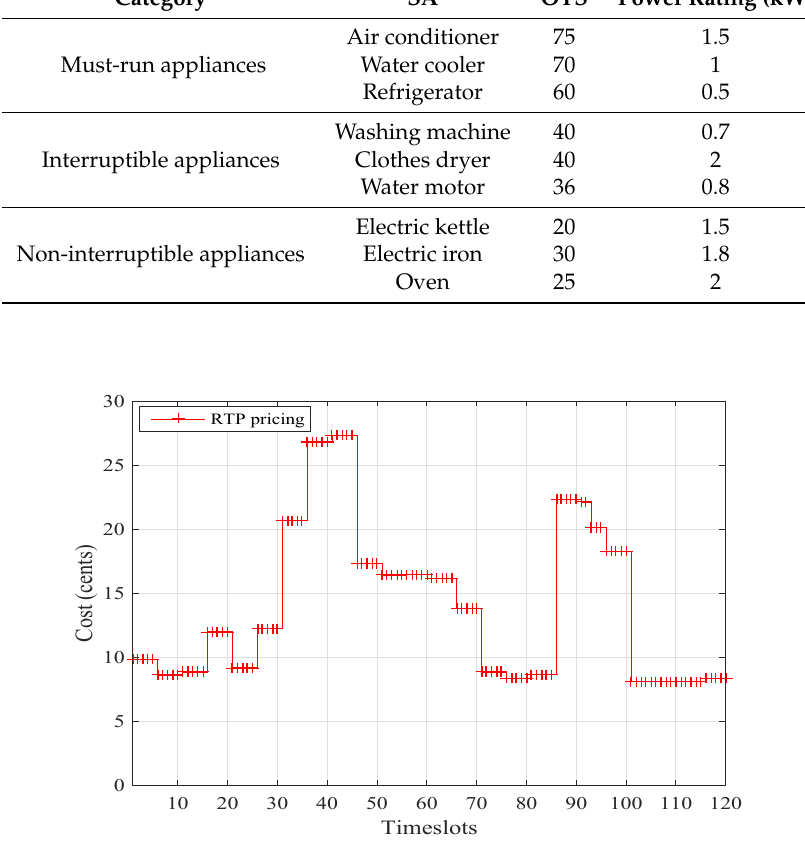
Figure 9. Real-time pricing (RTP)